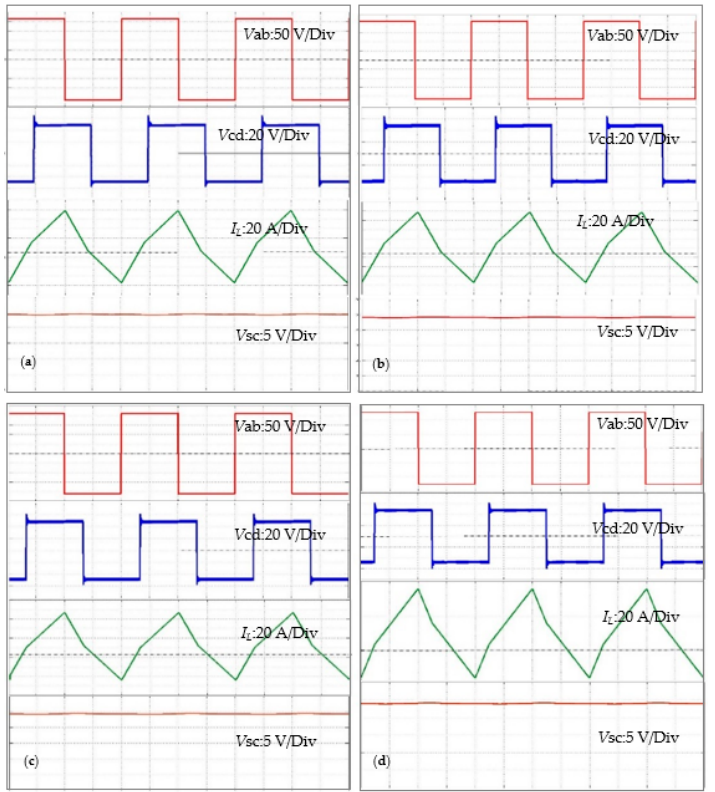
Figure 10. Experiment results of the SPS control DAB-IBDC converter at different input power ( a ) 2000 W; ( b ) 1900 W; ( c ) 1700 W and ( d ) 1400 W. Time scale: 5 ms/Div.